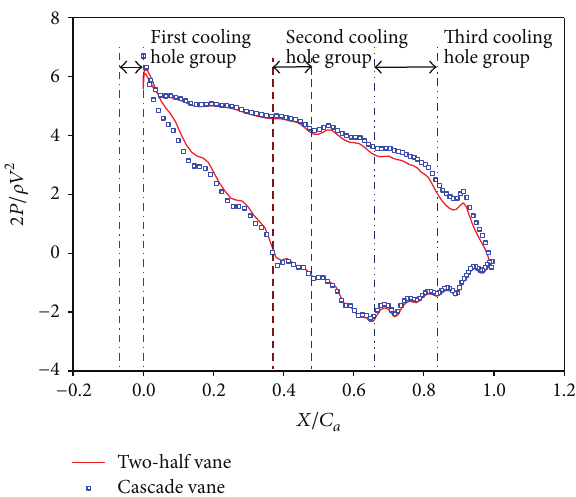
Figure 3: Comparison of the computed static pressure distributions for the two-half-vane model and a corresponding cascade.